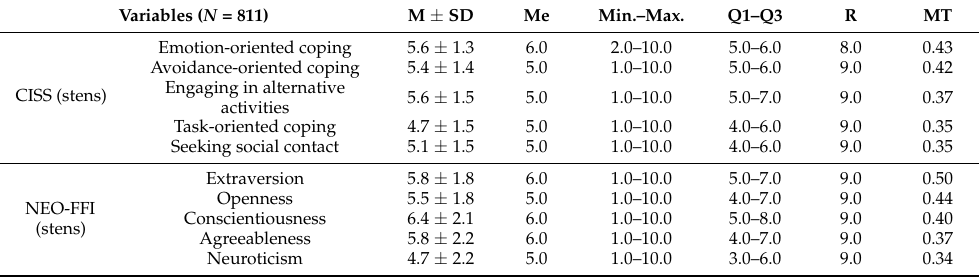
Table 2. Analysis of the styles of coping with stress according to CISS and personality traits according to NEO-FFI. Variables ( N = 811) M ± SD Me Min.–Max. Q1–Q3